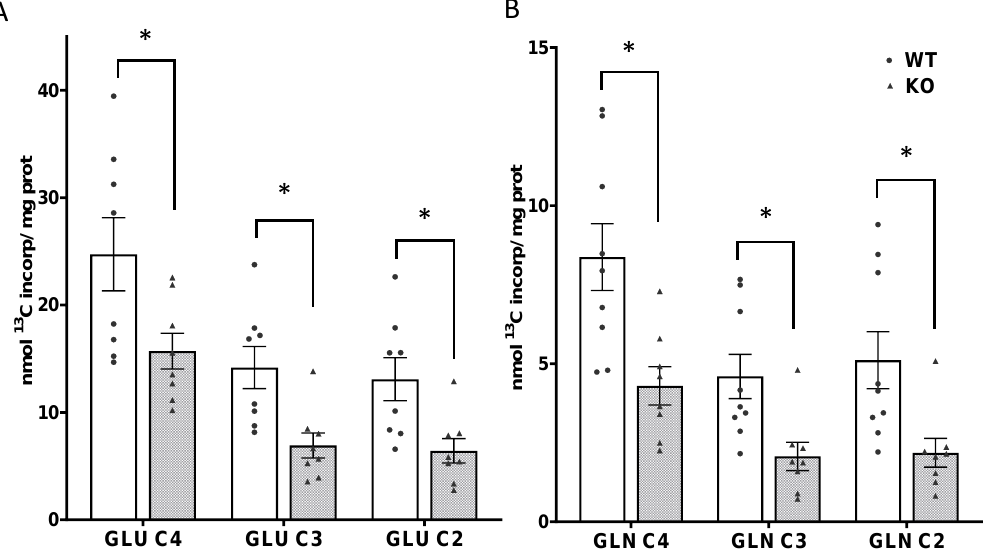
Figure 4. Incorporation of label from metabolism of [1,6- 13 C]glucose into newly synthesized isotopomers of glutamate ( A ) and glutamine ( B ) in brain from adult WT (white bars) and SIRT3 KO mice (gray bars). Individual data points are indicated by black circles and triangles. Note that the scale of the y-axis for glutamine is different than glutamate. Values are mean ± SEM nmol 13 C incorporated/mg protein from n = 9 WT and 8 SIRT3 KO mice. Data were analyzed by Student’s t -test, * p < 0.05.